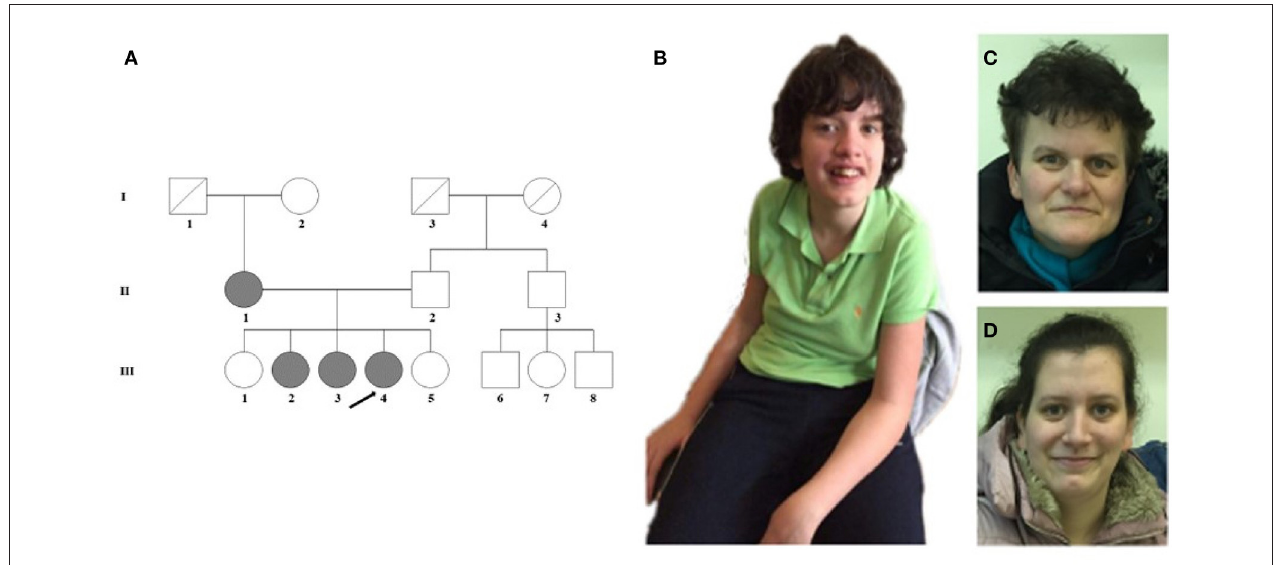
FIGURE 1 | (A) Pedigree of the family. (B) The proband (III-4) shows scoliosis and mild facial dysmorphic features such as low forehead, slight hypertelorism, prominent nose, and wide lips. (C) The minor facial anomalies of the mother (II-1): maxillary hypoplasia, prominent nose, and pointed chin. (D) Face of the sister (III-3) with almost no dysmorphic